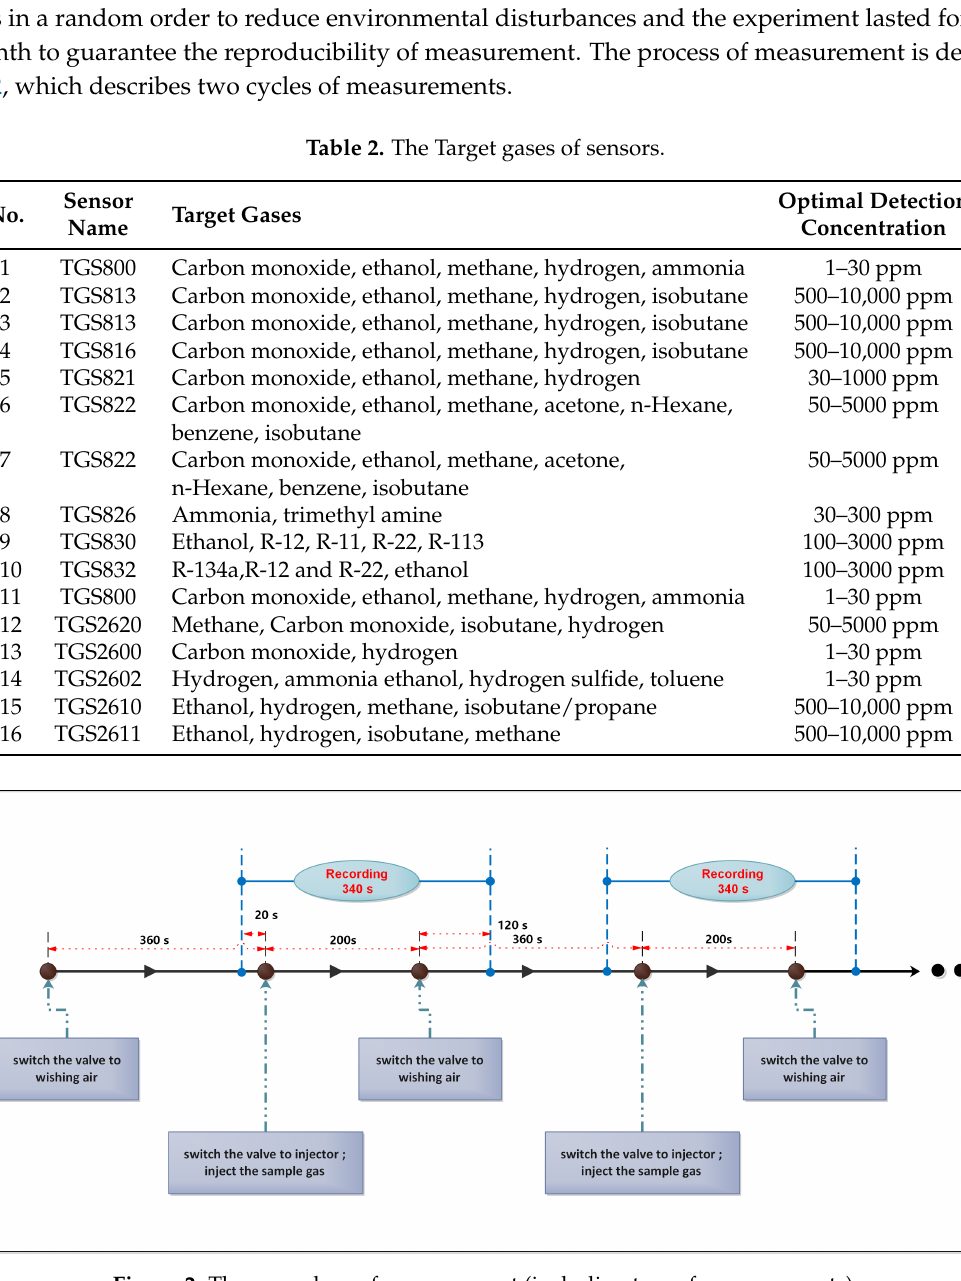
Figure 2. The procedure of measurement (including two of